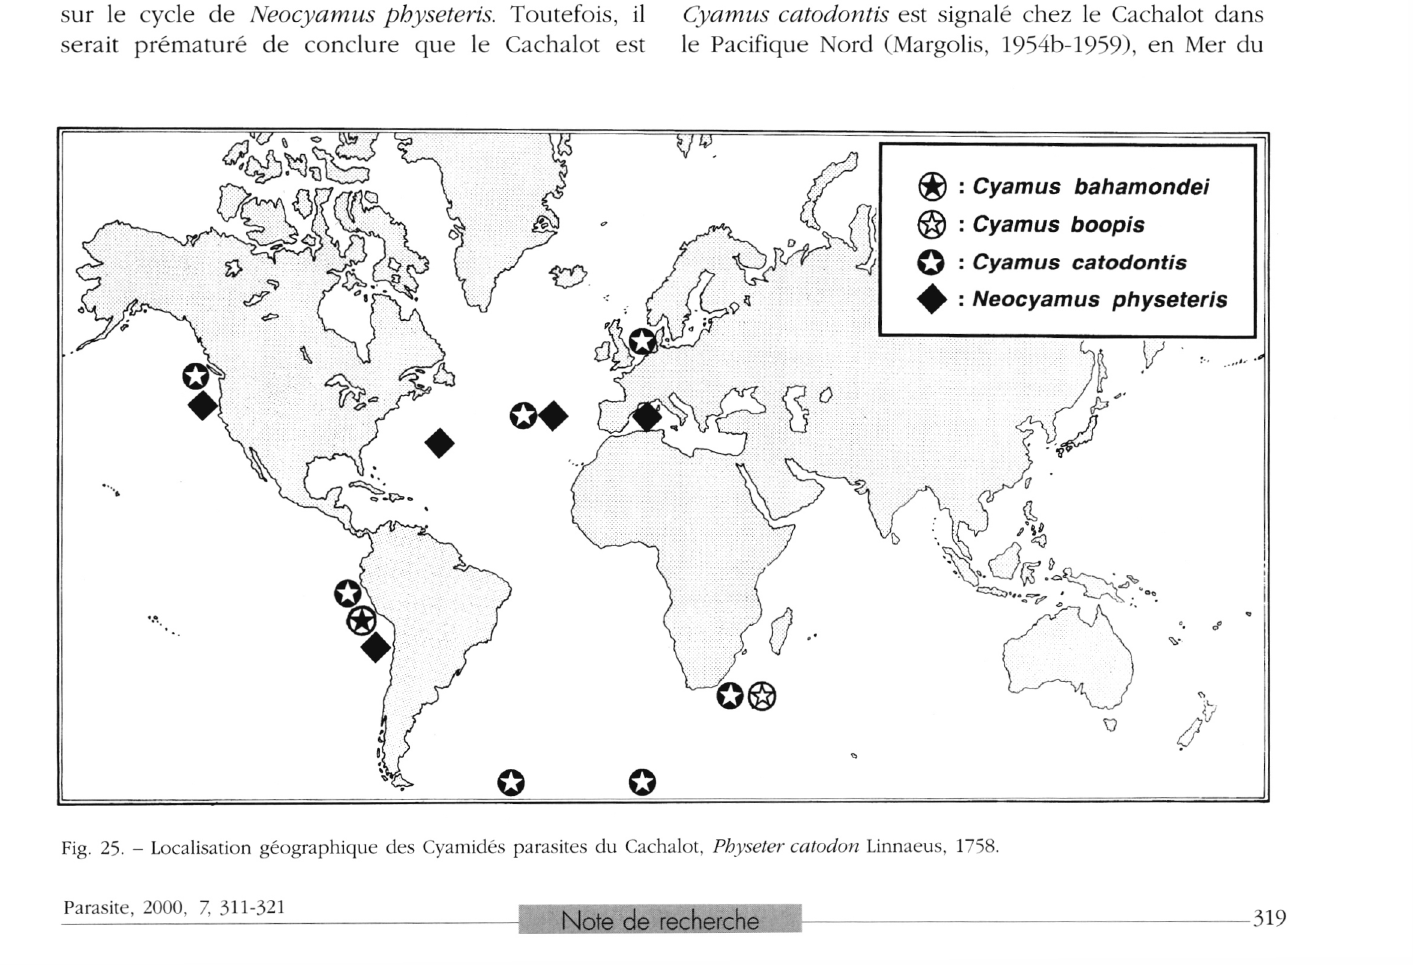
Fig. 25. - Localisation géographique des Cyamidés parasites du Cachalot, Physeter catodon Linnaeus,